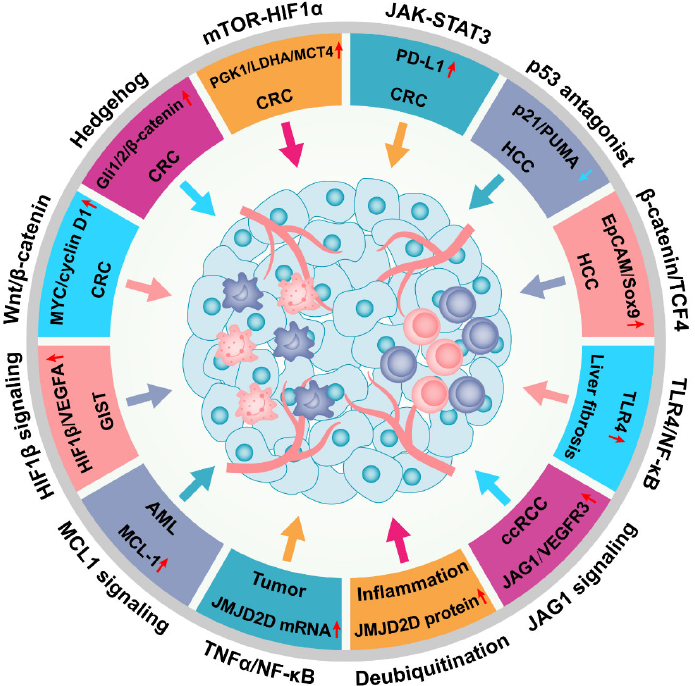
Figure 5. JMJD2D facilitates the progression of multiple malignant tumors by activating a variety of signaling pathways. JMJD2D promotes the progression of CRC by activating Wnt/ β -catenin, Hedge- hog, HIF1, and JAK ‐ STAT3 signaling; and JMJD2D serves as a pivotal facilitator in the pathogenesis of HCC through antagonizing p53 or elevating the transcription of EpCAM and SOX9. Furthermore, JMJD2D is crucial for the pathogenesis of GIST, AML, ccRCC, and liver fibrosis. In inflammation, JMJD2D can be transcriptionally upregulated by the activated TNF α‐ NF ‐κ B signaling, while both Trabid and TRIM14 can elevate the protein level of JMJD2D by reducing its ubiquitination.